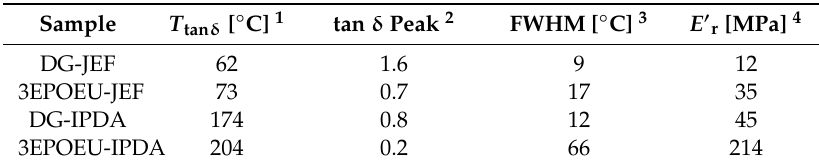
Table 4. Thermomechanical data of the materials studied.